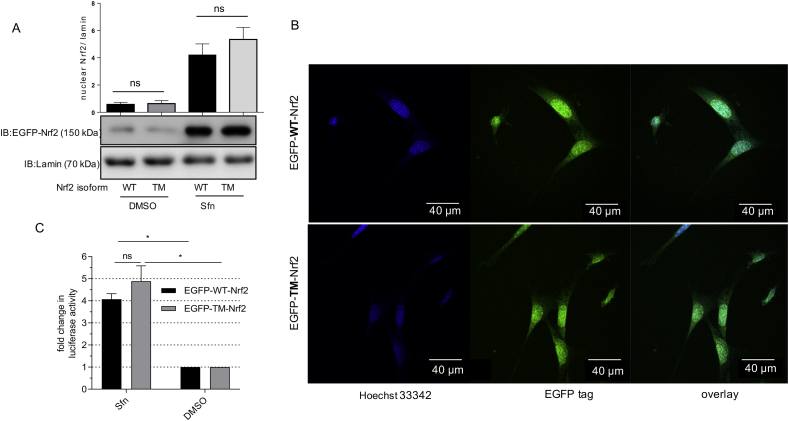
The identified AMPK-dependent phosphosites in Nrf2 do not affect nuclear translocation or transactivation of reporter gene expression. MEF were transfected with EGFP-tagged WT- or TM-Nrf2 and treated with DMSO as solvent control or Sfn (2 h, 5 μM). (A) Then nuclear fractions were prepared and blotted for GFP (=EGFP-WT- or EGFP-TM-Nrf2) and lamin. Representative blots and densitometric evaluation of three independent experiments are depicted. (B) Alternatively, cells were fixed. After staining nuclei with Hoechst 33342 cells were viewed under a confocal microscope (ex/em = 405/465 nm for Hoechst dye (nuclei) and ex/em = 488/520 nm (EGFP-Nrf2)). Only Sfn-treated transfected cells are depicted. (C) MEF Nrf2 −/− cells were transfected with EGFP-tagged WT or TM-Nrf2 expression plasmid together with an ARE-dependent luciferase reporter construct (ARE-LUC). Transfected cells were treated with DMSO or Sfn (5 μM) for 40 h before luciferase activity was determined. The bar graph depicts compiled data of at least three independent experiments expressed as fold luciferase induction by Sfn compared to DMSO-treated control cells (A, C: n ≥ 3, mean +SD, unpaired Welch's t-test, two tailed, α = 0.05, *P ≤ 0.05, ns: not significant).